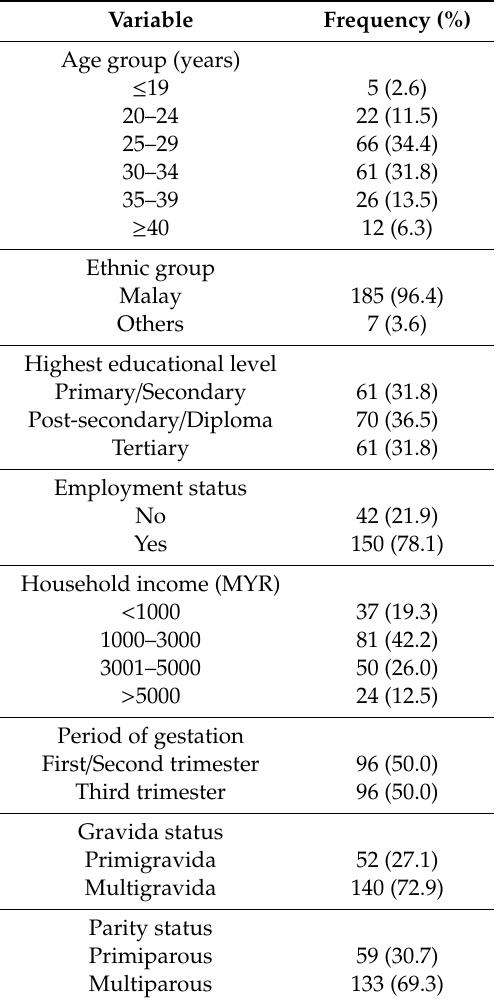
Table 1. Socio-economic and obstetric